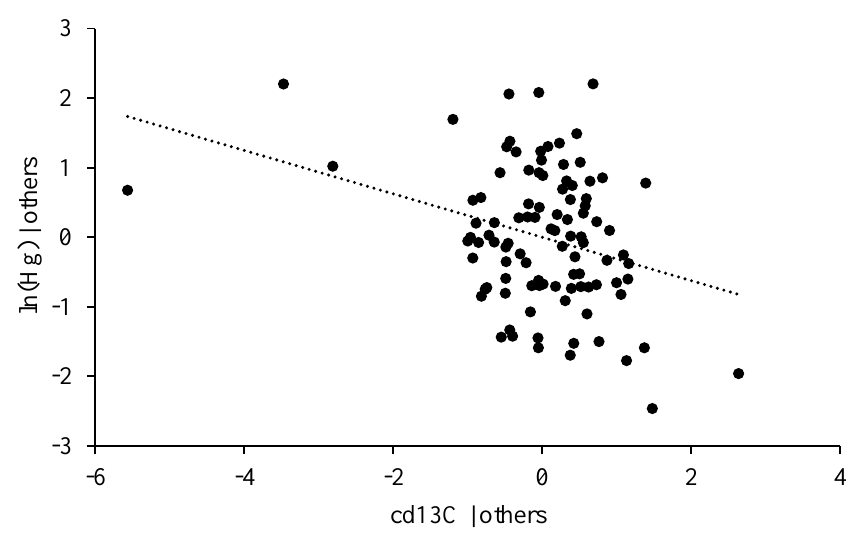
Figure 7. Partial linear regression between δ 13 C and Tot-Hg for E. smelt. All variables are corrected for the other explanatory variables included in the model.